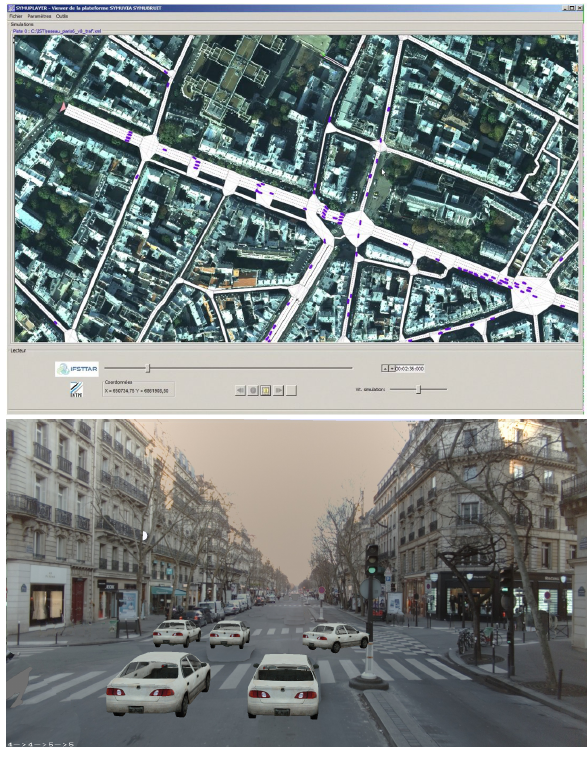
Figure 7: Top row: Original 2D view of the Symuvia simulator (Leclercq, 2007), IFSTTAR c (cid:13) . Bottom row: Augmented 3D visualization of the same traffic